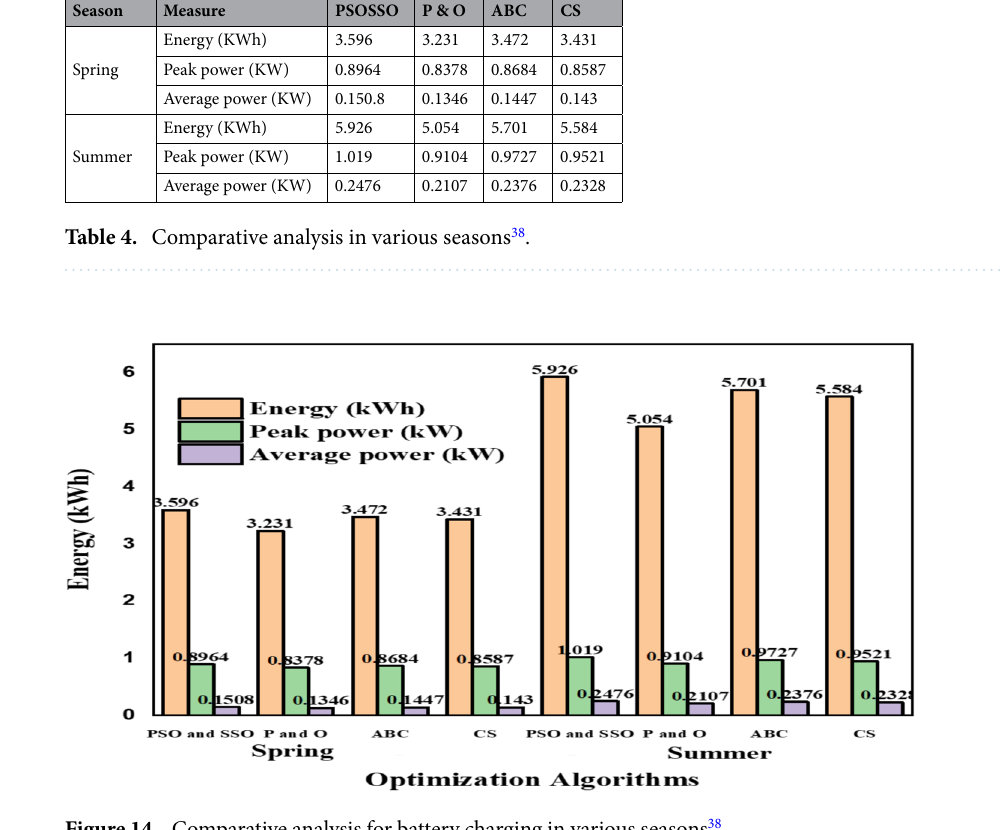
Figure 14. Comparative analysis for battery charging in various seasons 38